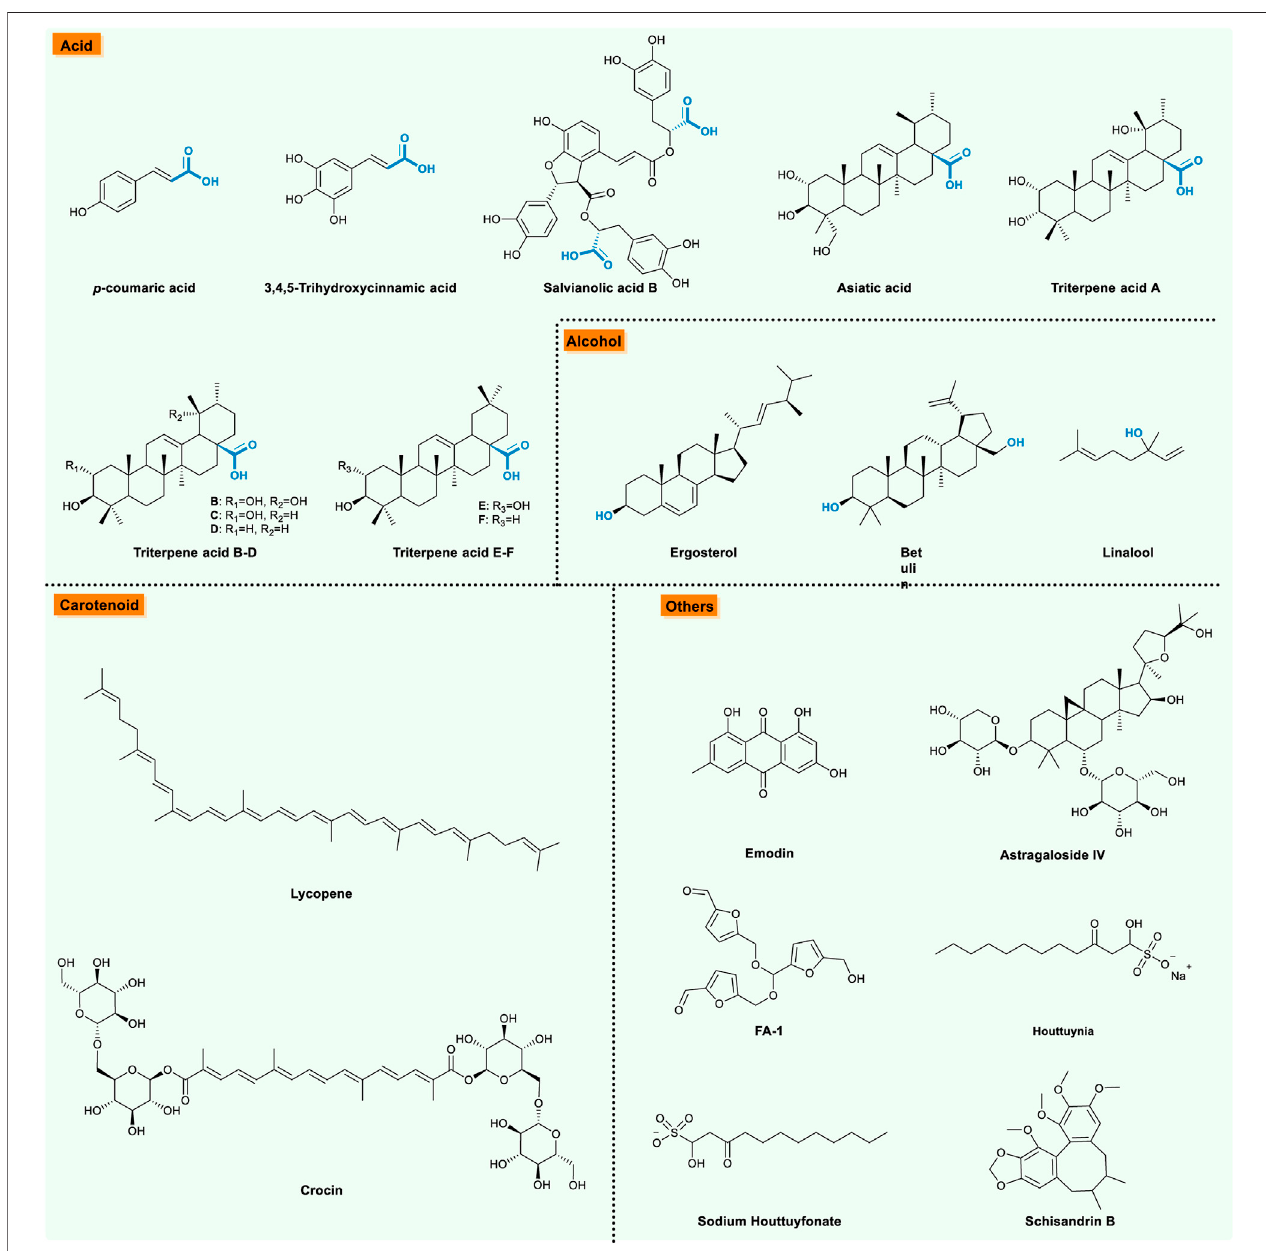
FIGURE 6 | The bioactive natural compounds from acid, alcohol, carotenoid – and others.